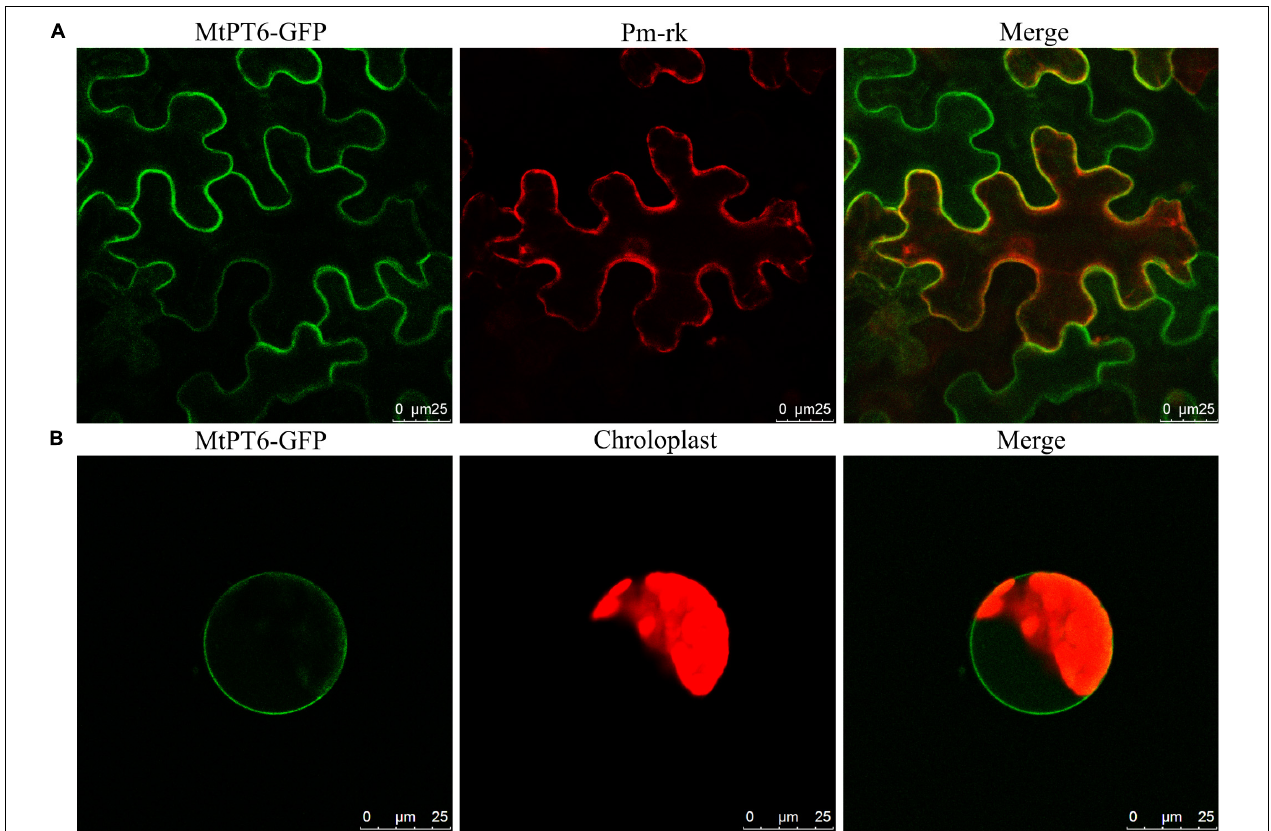
FIGURE 4 | Subcellular localization of MtPT6 gene. (A) MtPT6-GFP signal overlaid with a protoplast marker (pm-rk) in epidermal cells of tobacco leaves. (B) A protoplast isolated from mesophyll of tobacco. Scale bar, 25 µ m.